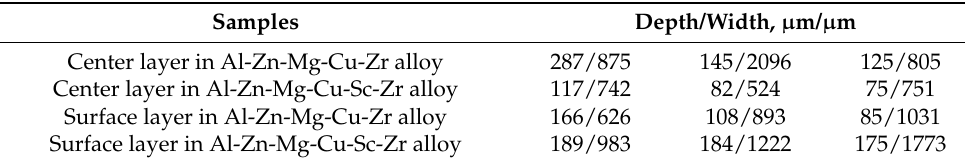
Figure 8. BSE images of representative intergranular corrosion area by SEM observation. ( a ) Al-Zn-Mg-Cu-Zr alloy in the central layer, ( b ) Al-Zn-Mg-Cu-Sc-Zr alloy in the central layer, ( c ) Al-Zn-Mg-Cu-Zr alloy in the surface layer, ( d ) Al-Zn-Mg- Cu-Sc-Zr alloy in the surface layer. Table 3. Corrosion depths and widths at the representative IGC